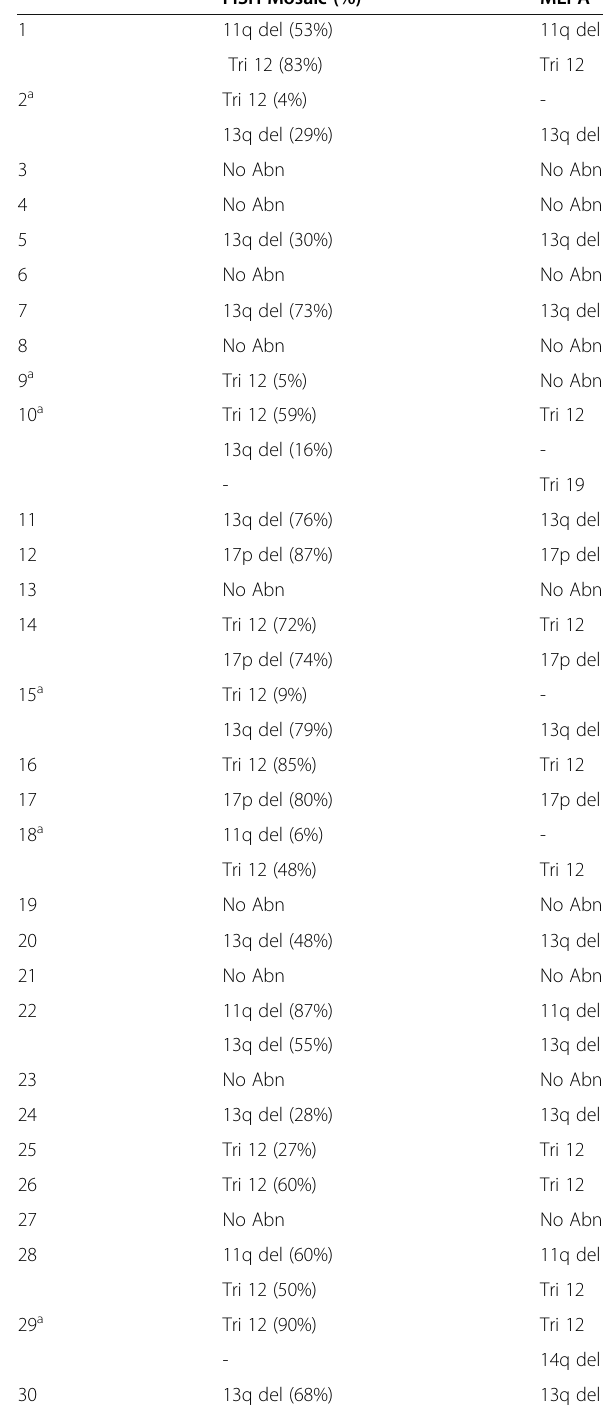
Table 1 Summary of the aberrations detected by MLPA and